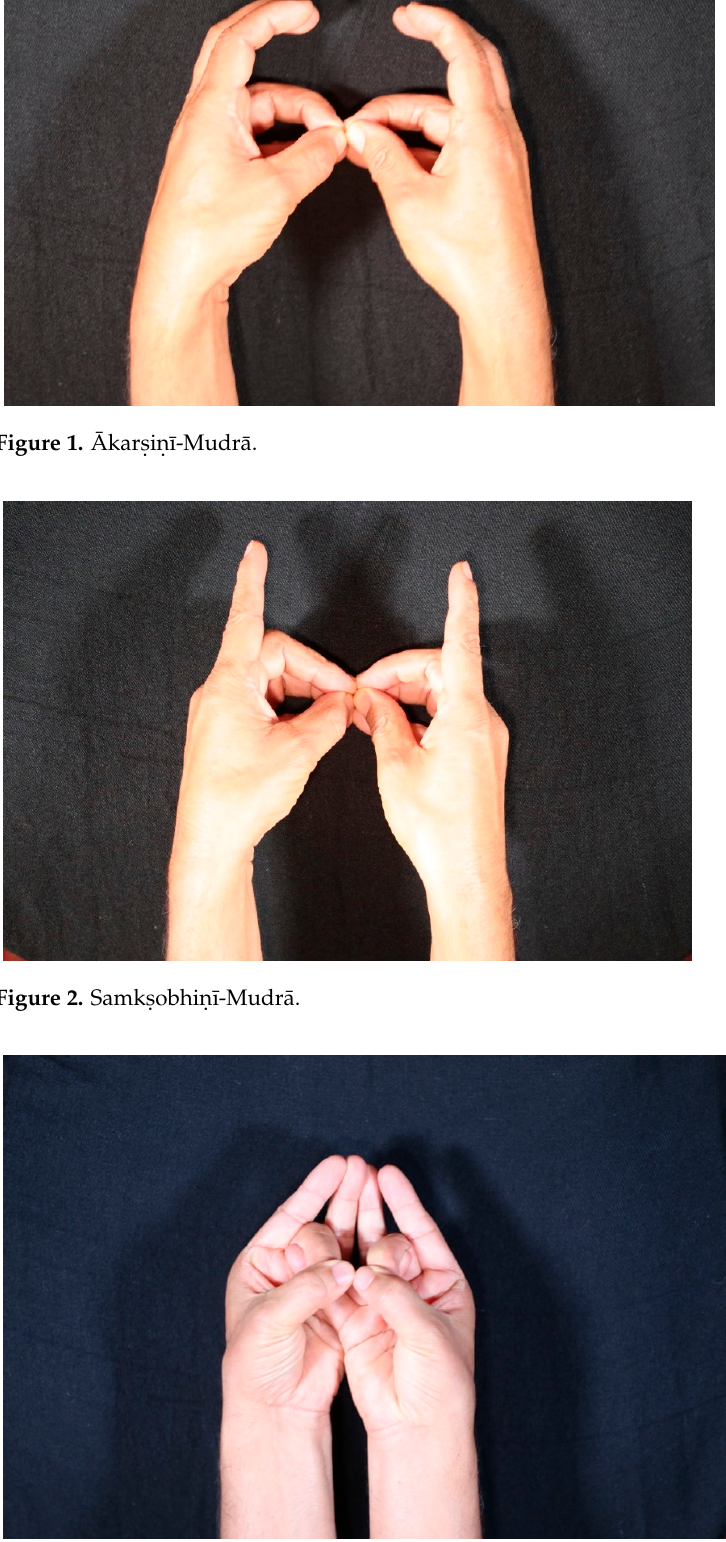
Figure 4. Mah ā ṅ ku śā -Mudr ā .